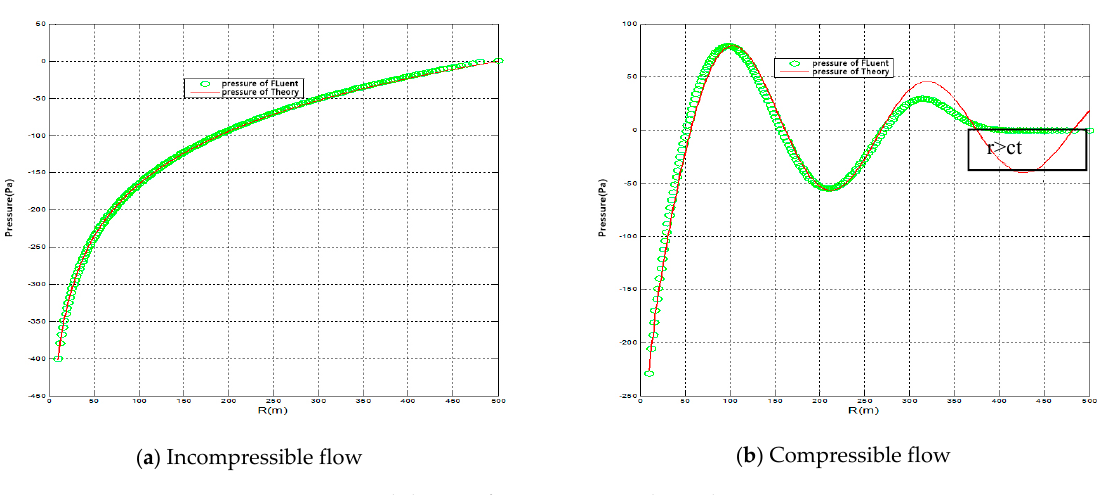
Figure 4. Validation of pressure vs. radius when t = 1.0 s.